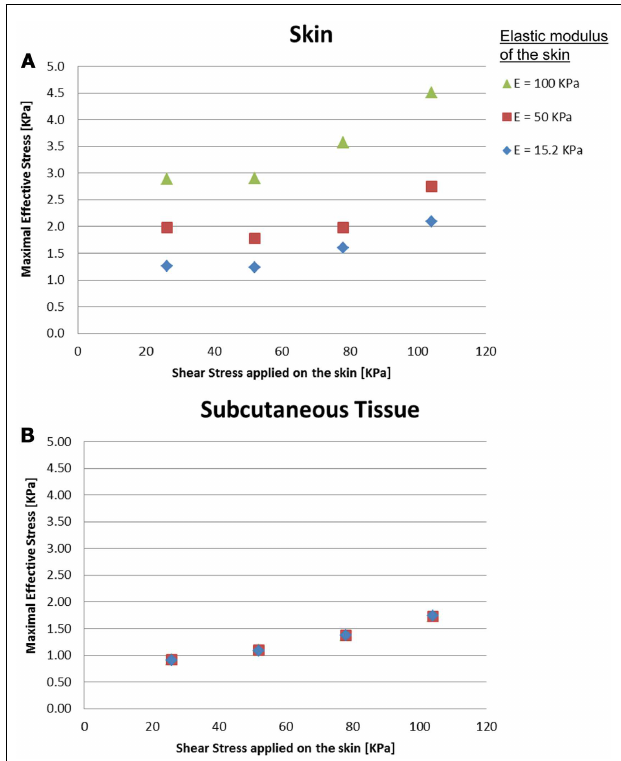
FIGURE 3 | Effects of a change in skin stiffness on maximal interface shear stress (A) and on maximal interface effective stress (B) .